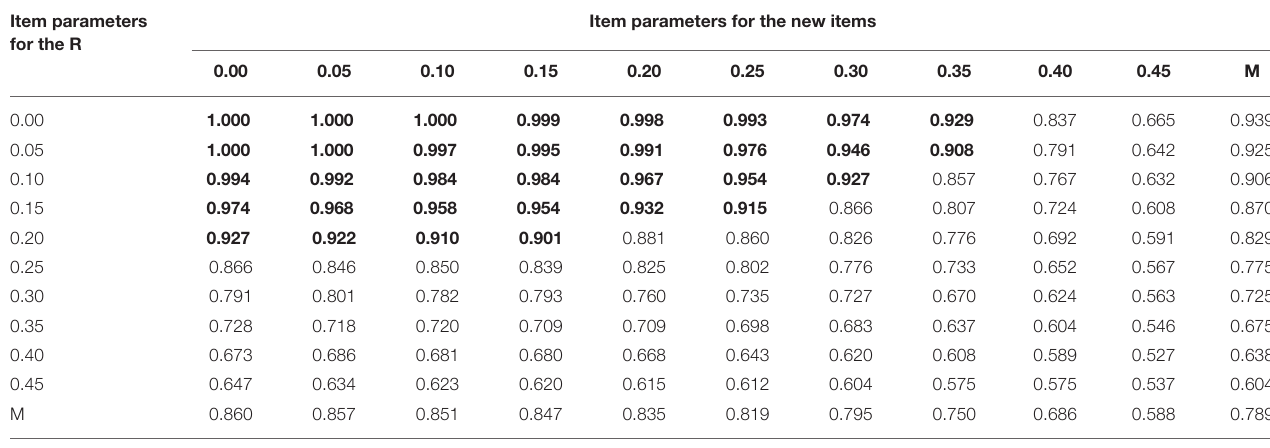
Item parameters for the new items